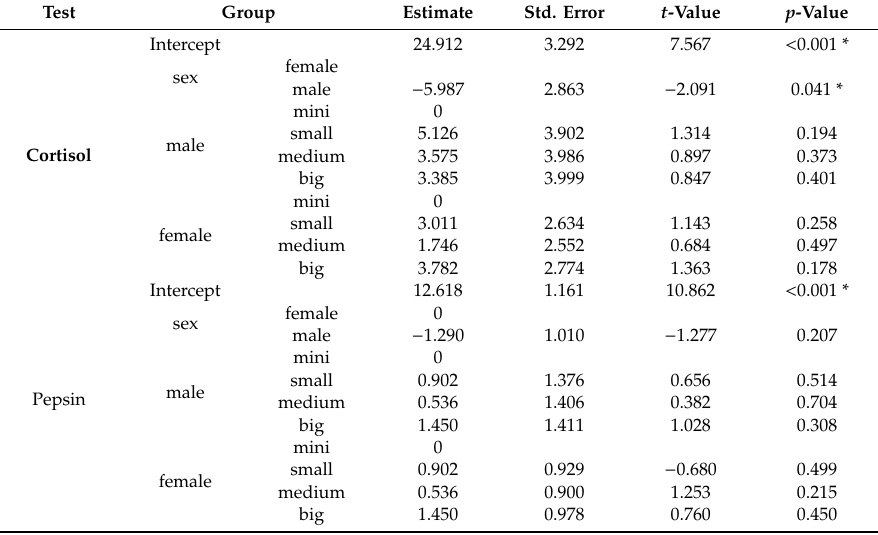
Table A3. E ff ects of group and sex on physiology as indicated by a mixed linear model. Sex di ff erence on cortisol was observed. Significant di ff erences were reported at * p <